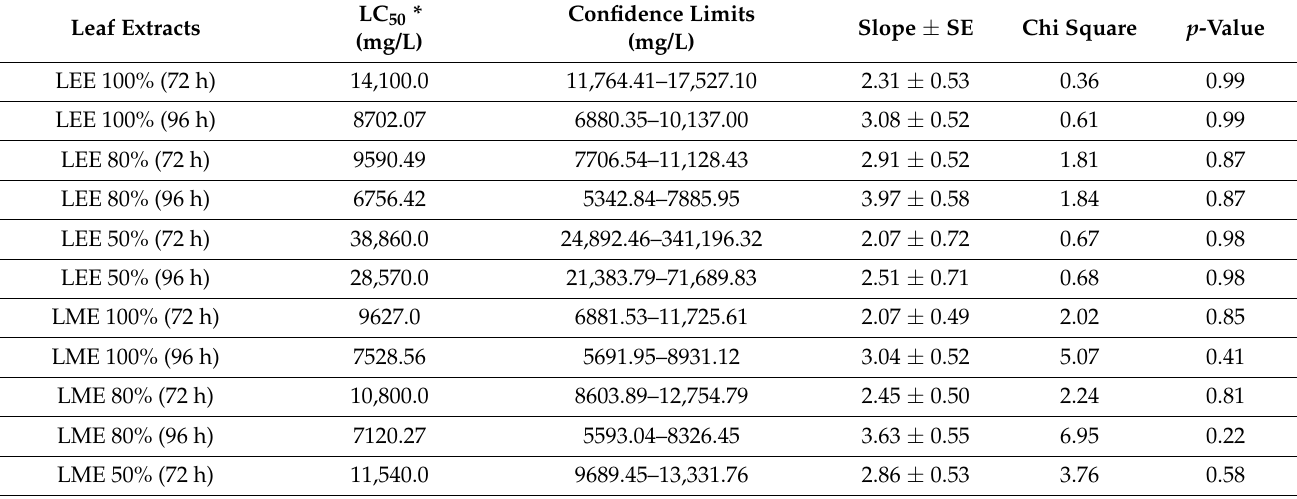
Table 3. Efficacy of ethanolic/methanolic leaf/bark aqueous extracts and SO of Triadica sebifera against Aphis craccivora